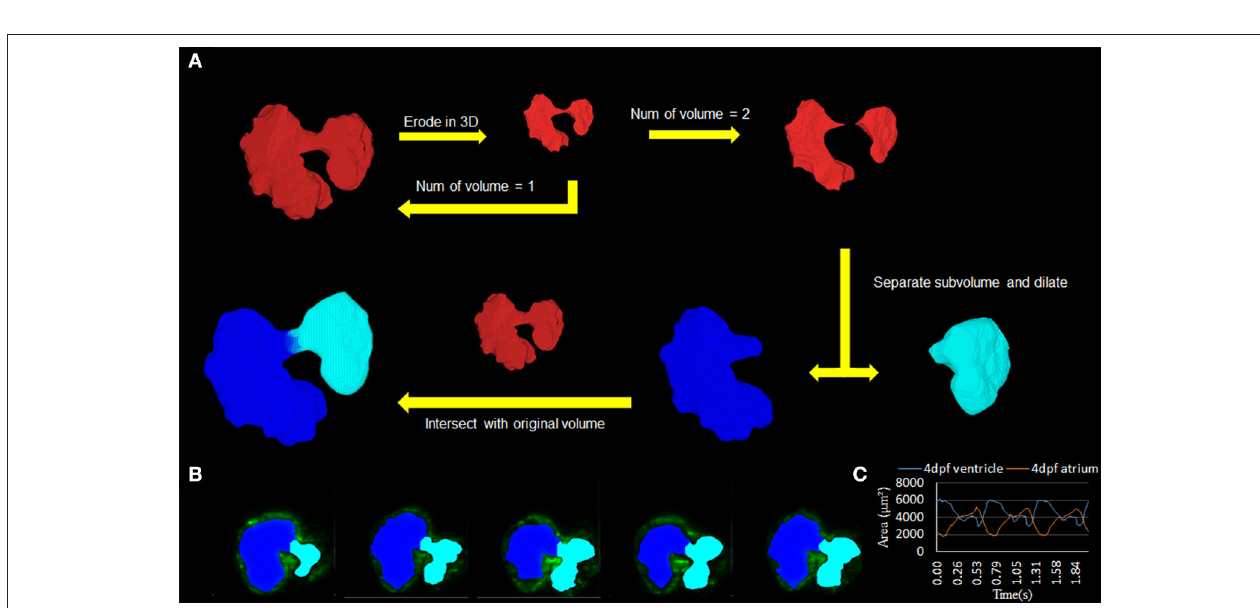
FIGURE 4 | Subdivision of atrium and ventricle. (A) Methodology of using the automatic segmentation to define the morphology of inner volume of the zebrafish heart. This method relies on an iterative process that uses an erosion operator on the 3D structure of the inner volume until division occurs. Following the division of the volume into two separate components, extraction of each individual piece follows with a dilation operation and intersection with the original volume. (B) 2D axial slices showing the differentiation of the atrium (teal) and ventricle (blue) of various slices. (C) Area change over time from 2D slice (B) was successfully demonstrated.